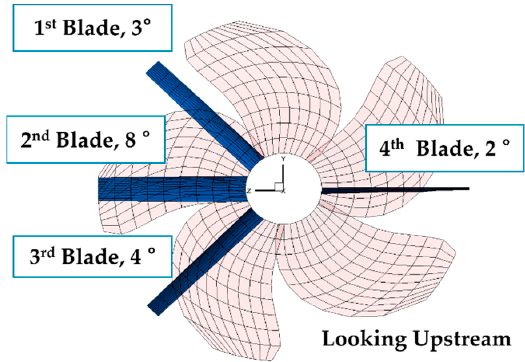
Figure 6. Optimal pitch angle of each blade in the initial PSS.